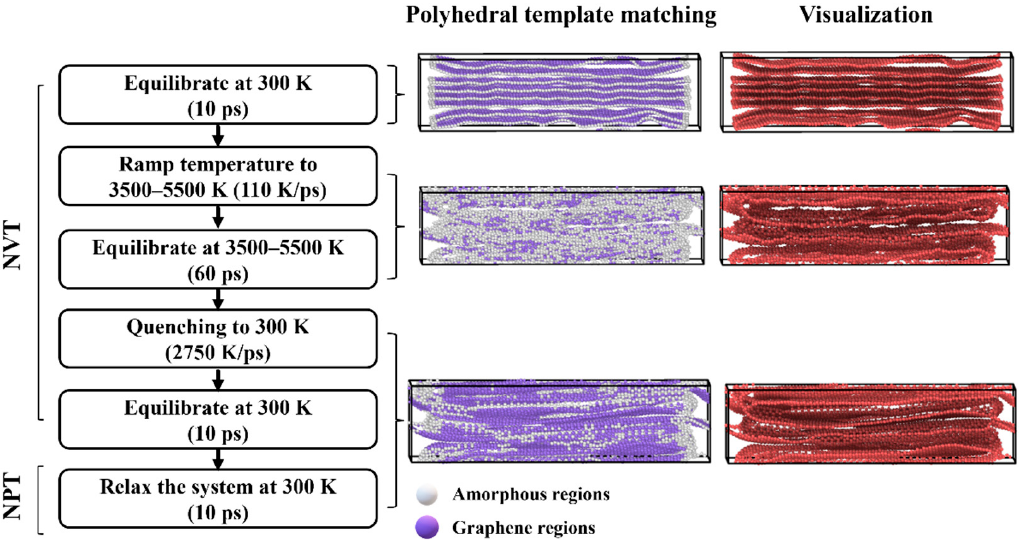
Figure 2. Molecular dynamic simulation steps for building a carbon fiber structure via annealing methodology using the NVT and NPT ensembles with different graphene regions percentages and turbostratic arrangements. Polyhedral template matching represents the amorphous regions in white and the graphene regions in purple.